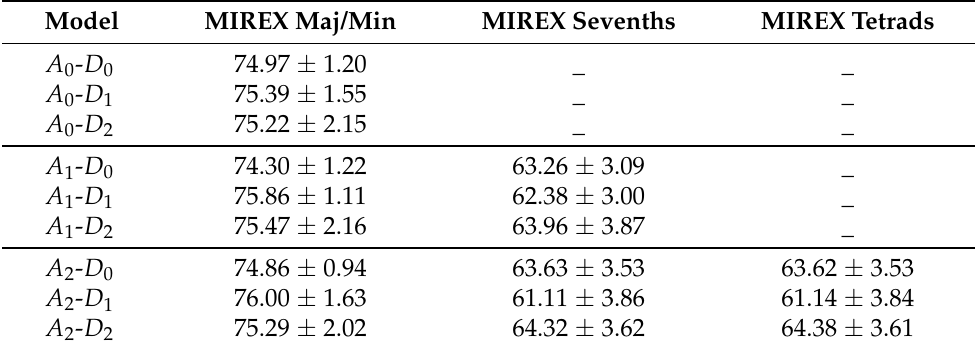
Table 1. Results of the 5-fold with the standard deviation: evaluation on MIREX Maj/Min ( ∼ reduction on A 0 ), MIREX Sevenths ( ∼ reduction on A 1 ) and MIREX Tetrads ( ∼ reduction on A 2